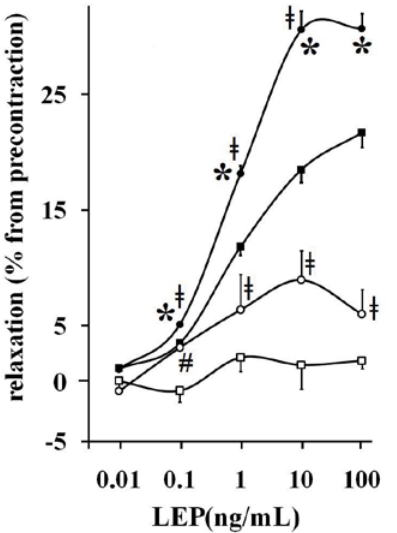
Figure 4. Vascular response of pulmonary artery rings from ovalbumin- sensitized rats precontracted with phenylephrine to increasing doses of leptin (LEP), either alone (squares) or after preincubation with apelin (circles). The vehicle effects alone or in the presence of apelin are presented as empty squares and circles. *P<0.05 as compared with LEP effects alone (n=6). #P<0.01 in the presence of apelin as compared with vehicle alone (n=6). ǂ P<0.05 compared to normal rats (see text for details). The LEP or vehicle effects are expressed as a percentage of Phe- induced precontraction (mean ± S.E.M.)